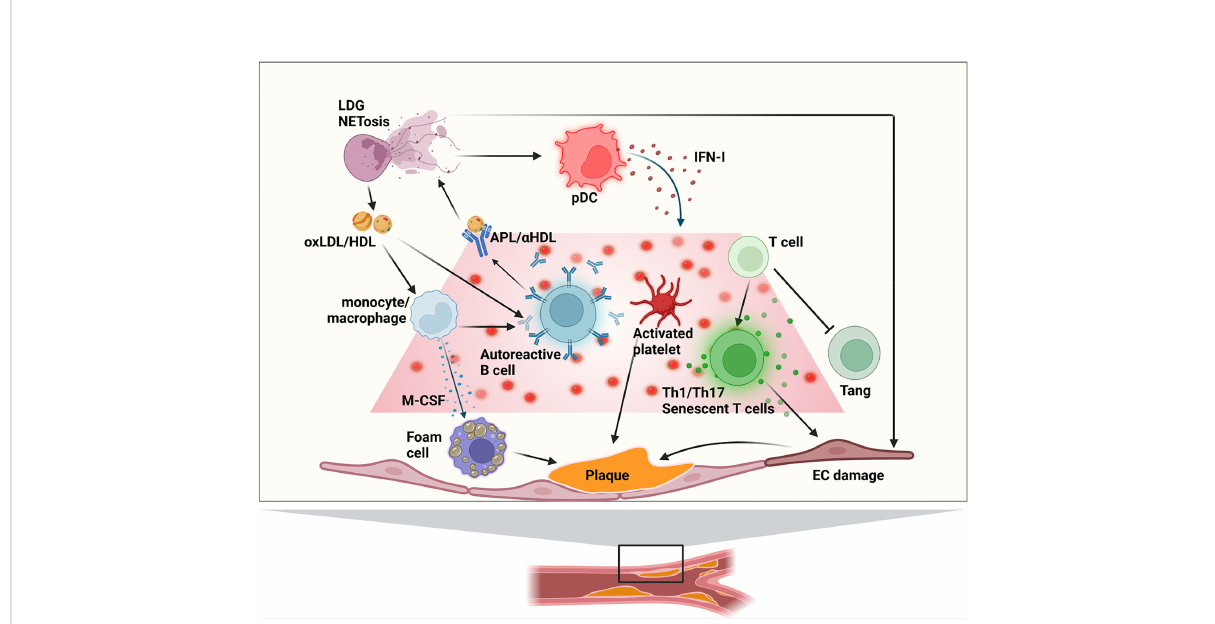
FIGURE 1 Main immune mechanisms of involved atherogenesis in SLE patients. APL, anti-phospholipid antibody; EC, endothelial cell; (ox)HDL, (oxidized) high-density lipoprotein; IFN-I, type I interferon; LDG, low-density granulocytes; (ox)LDL, (oxidized) low-density lipoprotein; pDC, plasmacytoid dendritic cell; Tang, angiogenic T